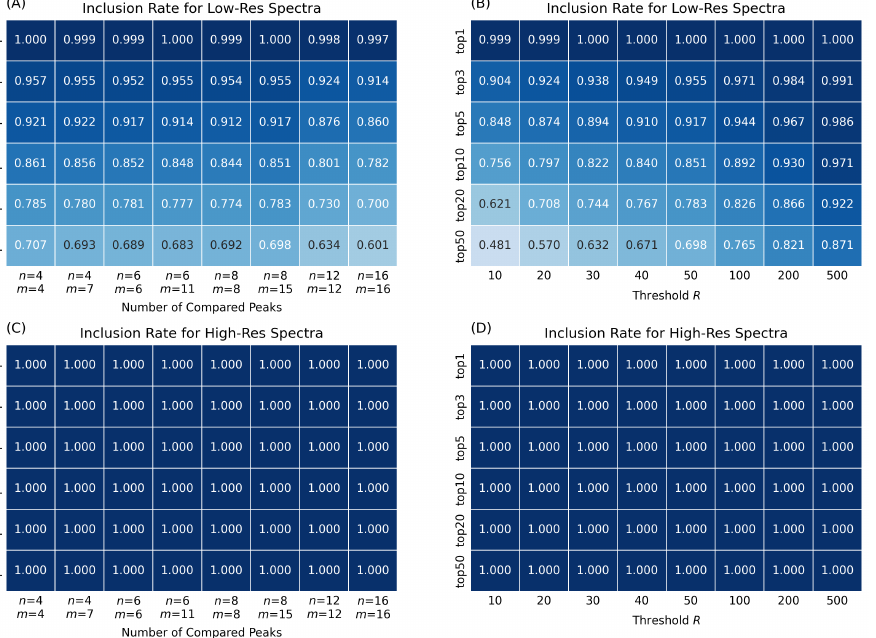
Figure 3. Inclusion rates of the new search algorithm, estimated for prescreening parameters ( n , m , R ) , where n is the number of query spectrum peaks participating in the prescreening search, m the number of library spectrum peaks participating in the prescreening search, and R determines the number of candidate spectra returned by the prescreening search: ( A , B ) search against low-resolution spectra; ( C , D ) search against high-resolution